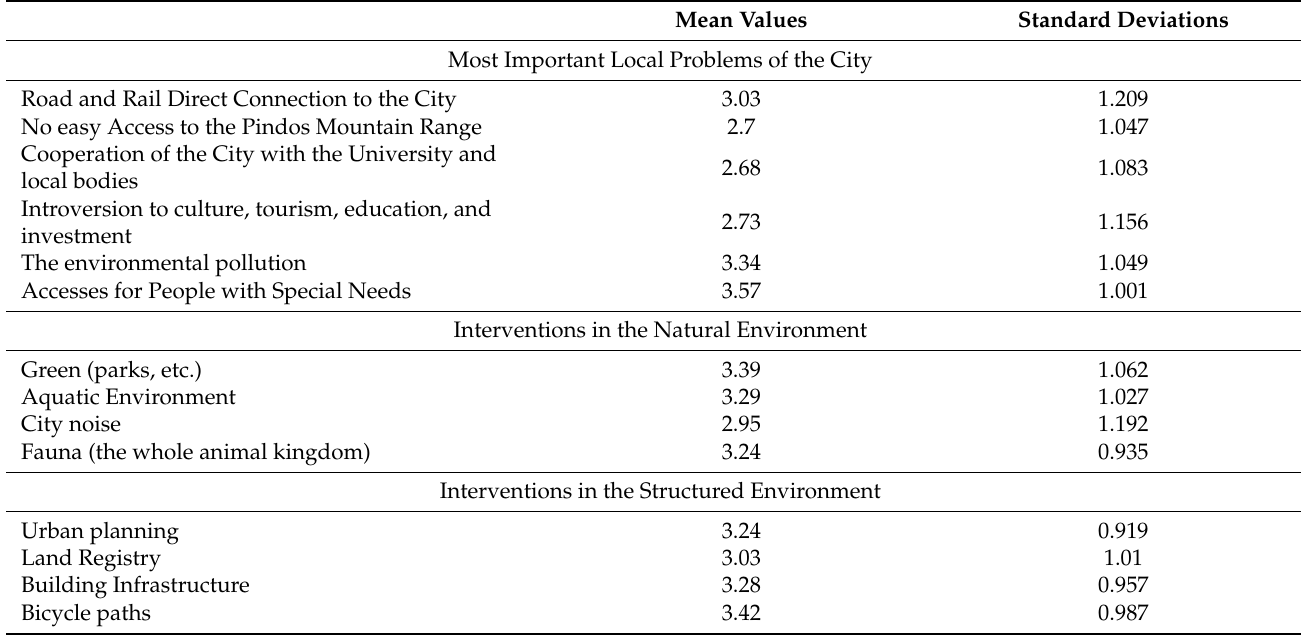
Table 1. Descriptive statistical analysis (Mean Values, Standard Deviations) for the Research Ques- tionnaire